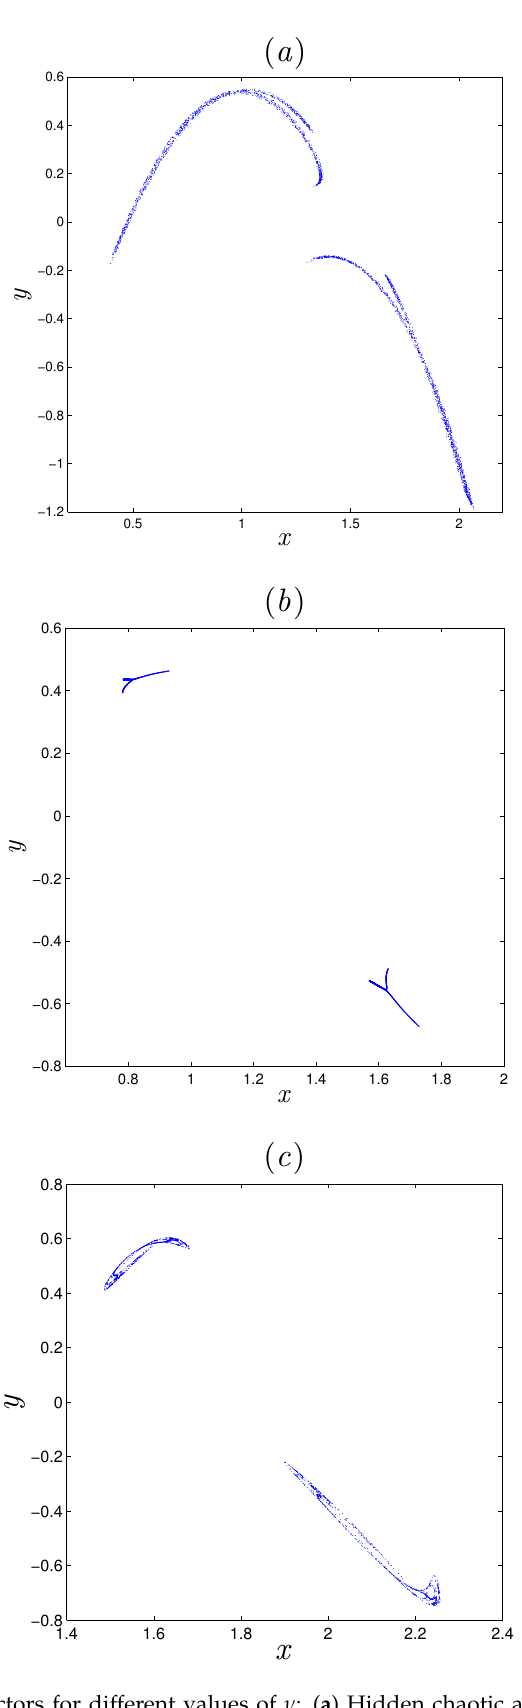
Figure 4. Hidden attractors for different values of ν : ( a ) Hidden chaotic attractor for ν = 0.0852; ( b ) Hidden periodic attractor for ν = 0.2931; ( c ) Hidden chaotic attractor for ν =